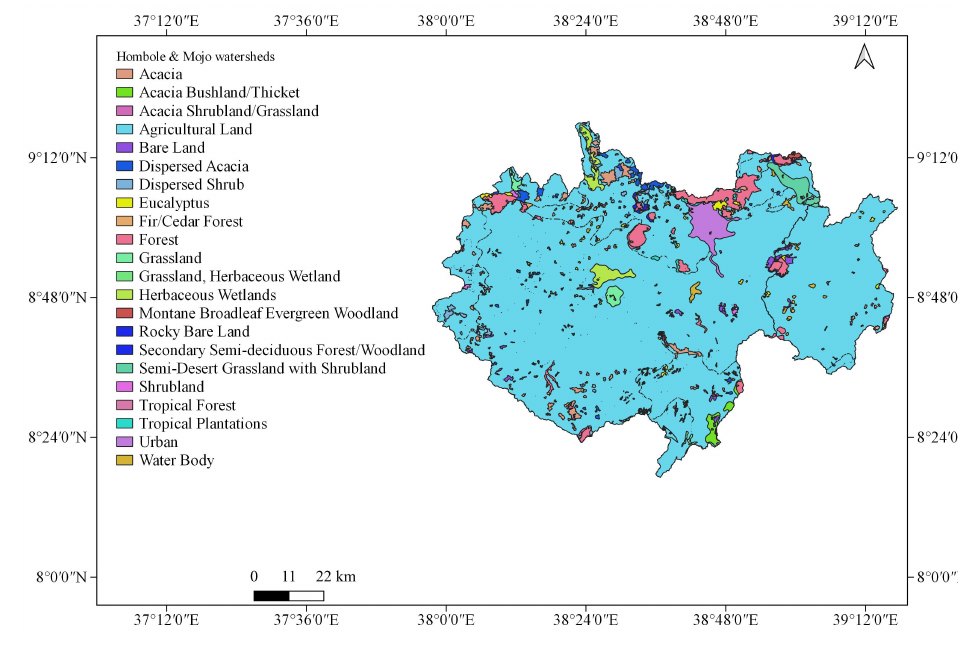
Figure 9. Land use map of the Hombole and Mojo Watersheds from 1989 to 2000.